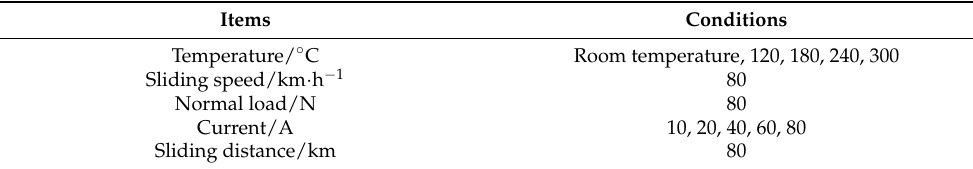
Table 1. Parameters of the test.